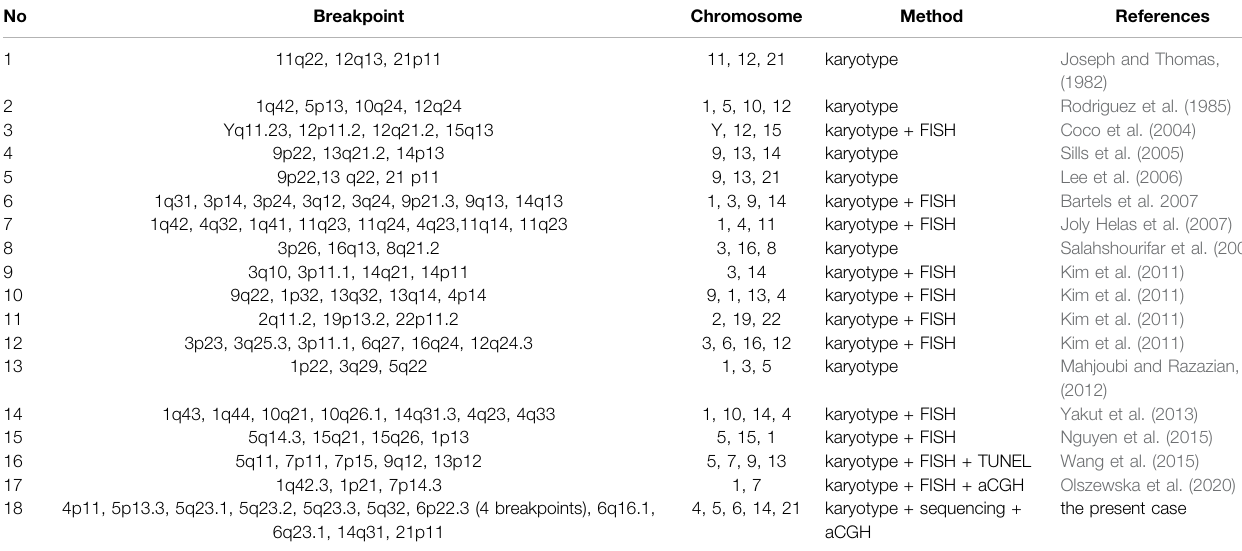
TABLE 3 | Published cases of CCRs in males with